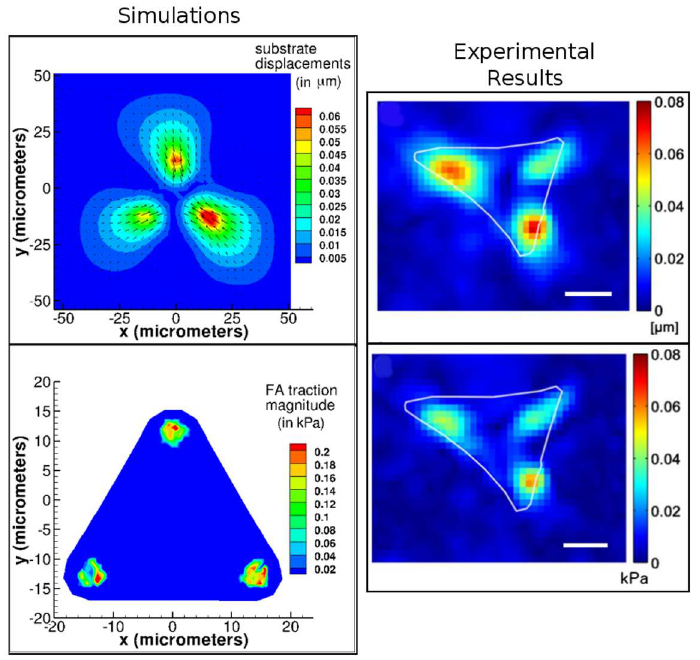
Fig 4. Comparison of simulations to contraction of a cardiomyocyte. Our simulations are shown in the left panel,and experiments from Hersch et al. [40] are on the right ( with permissionunder CC-BY 4.0 license ). Experimental result figures were modifiedfrom originalby including scale bar and removingletter referringto originalfigure from top left corner. Scale bar = 10 μ m . The substrate displacements from simulations compare well to those obtained experimentally both qualitatively and quantitatively. FA tractions, whose magnitudes are illustratedas contours, comparewell qualitatively. Cell and substrate Young’smodulus: E c = 20 kPa, E s = 15 kPa. FA springs rupture at a stretch of 0.4 μ m.